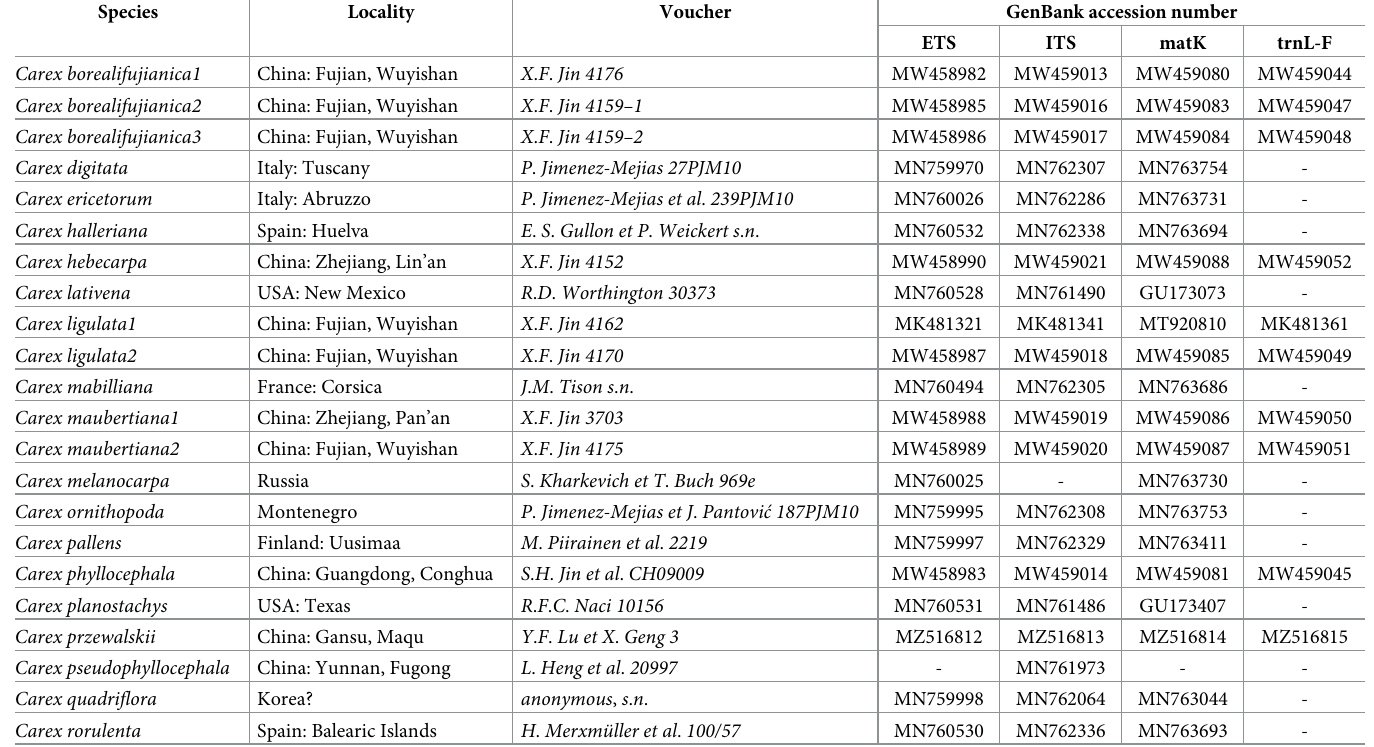
Table 1. Sampling information of the species used in the phylogenetic analysis of Carex borealifujianica